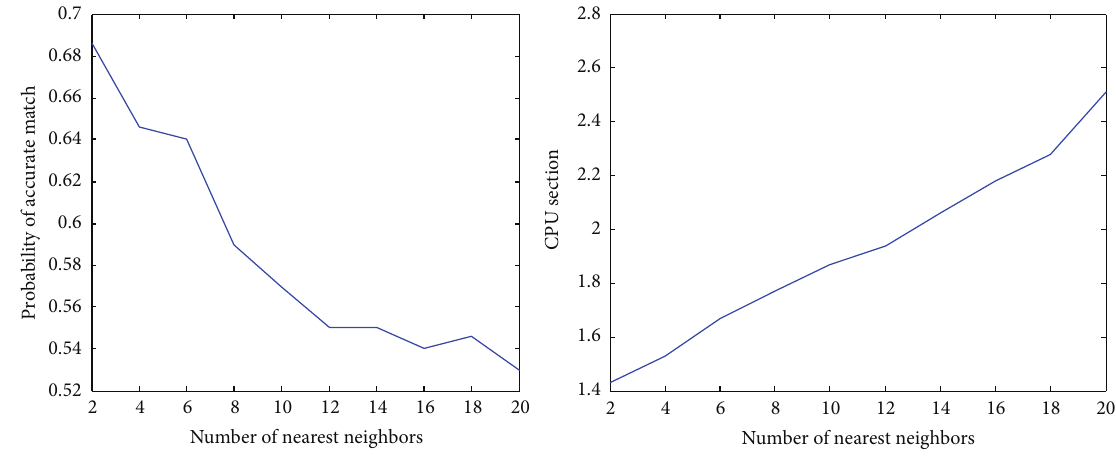
Figure 4: Classification beyond CPU load